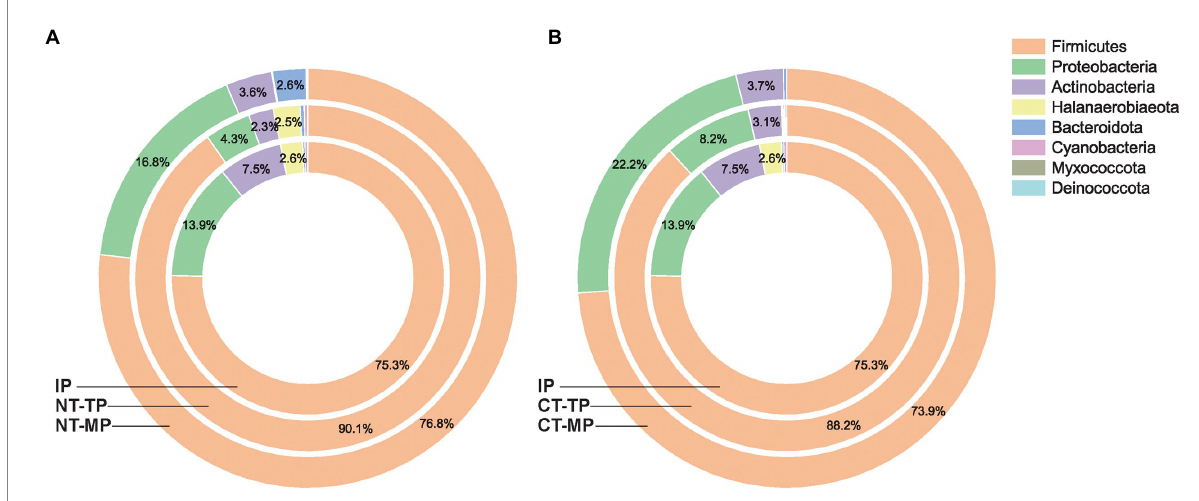
FIGURE 4 Dynamic changes in community composition of sorted transconjugant pools at the phylum level in the normal thermophilic (A) and continuous thermophilic composting (B) . NT and CT represent normal and continuous thermophilic composting, respectively; IP, TP, and MP represent the initial, thermophilic, and mature phases,